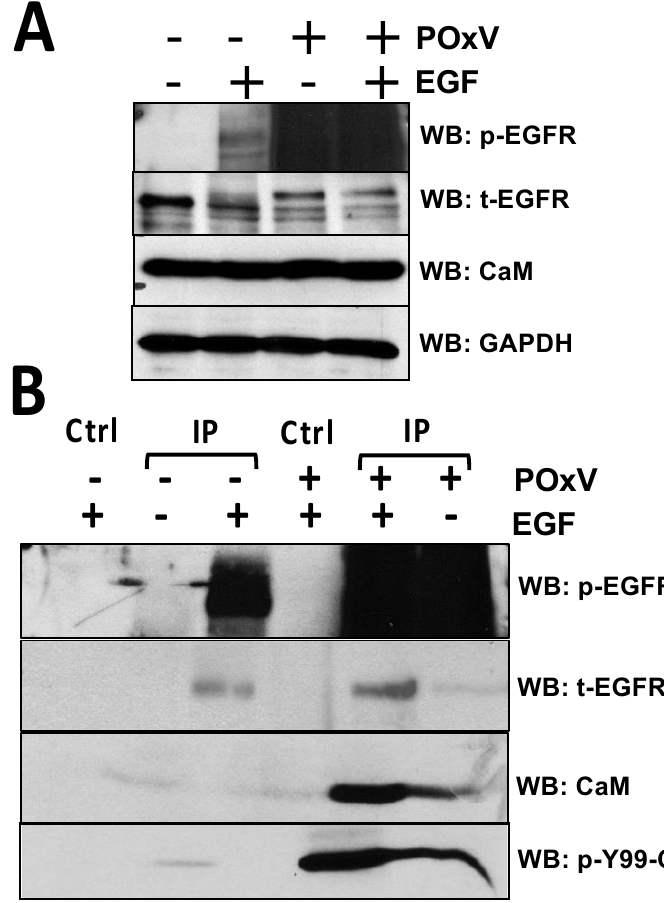
Figure 2. The EGFR phosphorylates CaM. ( A ) HeLa cells were treated in the absence and presence of 1 mM peroxovanadate (POxV), a cell permeable tyrosine phosphatase inhibitor and thereafter stimulated with 20 nM EGF for 5 min. The level of phospho-EGFR ( p-EGFR ), total EGFR ( t-EGFR ) and CaM were determined using Western blot ( WB ) in the total cell extract with a monoclonal (rabbit IgG) anti-EGFR antibody (clone E235) from Millipore recognizing the C-terminal region, a monoclonal (mouse IgG 2b κ ) anti-phospho-tyrosine antibody (clone 4G10) from Upstate Biotechnology recognizing anti-phospho-EGFR and a monoclonal (mouse IgG 1 ) anti-CaM antibody from Millipore, respectively. GADPH, determined using a monoclonal (rabbit IgG) anti-GAPDH antibody (clone 14C10) from Cell Signaling Technology, is also shown as a loading control. The presence of POxV induced an extraordinary phosphorylation of the EGFR by preventing dephosphorylation, which results in the unavoidable overexposure of the X-ray film. ( B ) HeLa cells treated in the absence and presence of POxV and EGF, as in panel A , were lysed and immunoprecipitated (IP) with an anti-phospho-tyrosine antibody. Non-relevant protein A-agarose beads were used as control (Ctrl). Phospho-EGFR ( p-EGFR ), total EGFR ( t-EGFR ), CaM and phospho-tyrosine99-CaM ( p-Y99-CaM ) were determined using Western blot ( WB ) with anti-phospho-tyrosine, anti-EGFR, anti-CaM and anti-phospho-Tyr99-CaM antibodies, respectively (Sánchez-González and Villalobo, additional data to [30,31,37]).